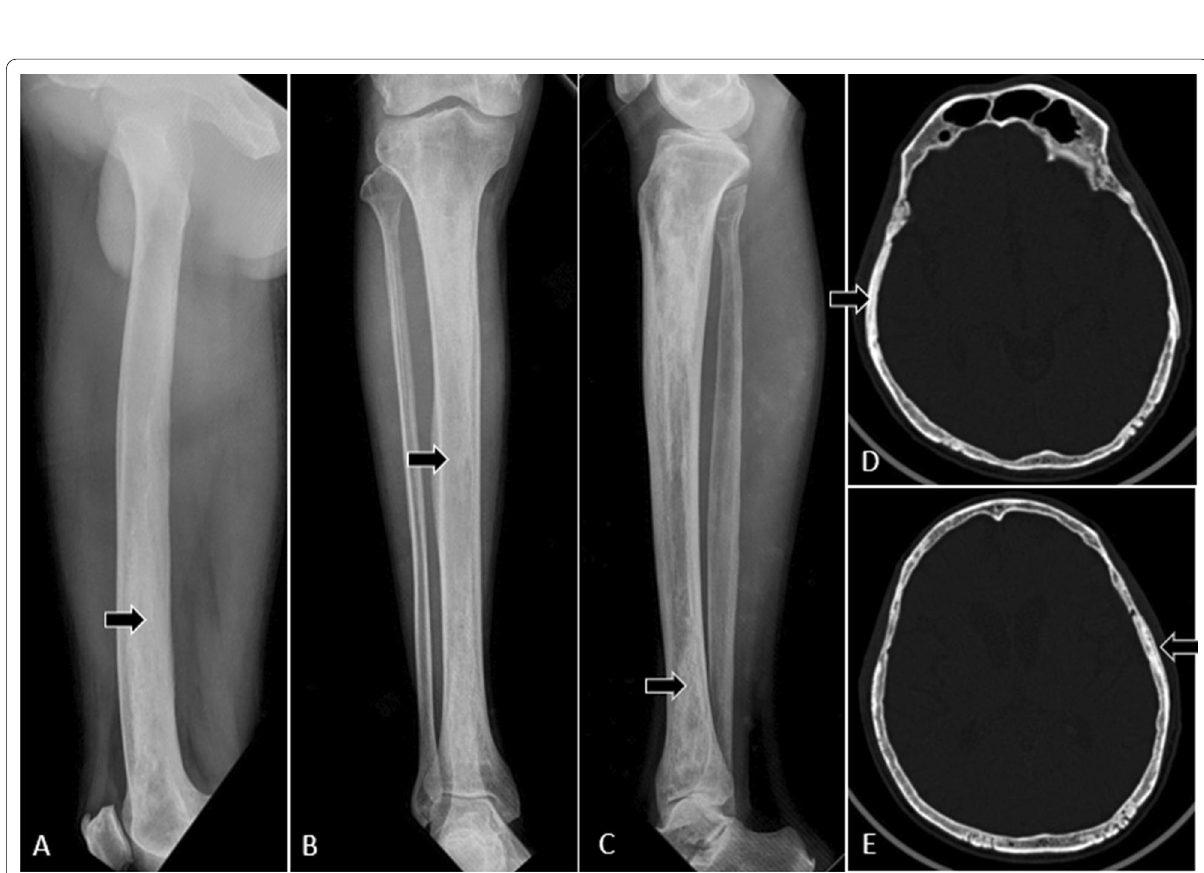
Fig. 5 Radiographs of a 60-year-old male patient diagnosed with Erdheim–Chester disease reveals regions of diffuse sclerosis with loss of cortico-medullary differentiation in diaphysis and metaphysis of right femur ( A , B ) and tibia ( C ) with bone within bone appearance. Computed tomography of the brain reveals ill-defined areas of sclerosis in the calvarium ( D , E